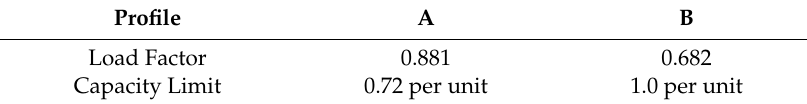
Table 3. Capacity Rating (% Nameplate) for Profile A & B.